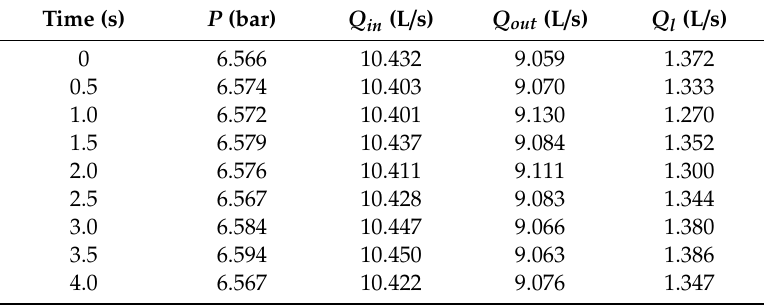
Table 3. Example of data acquisition in operating condition for Q in = 10 L / s and P = 6.5